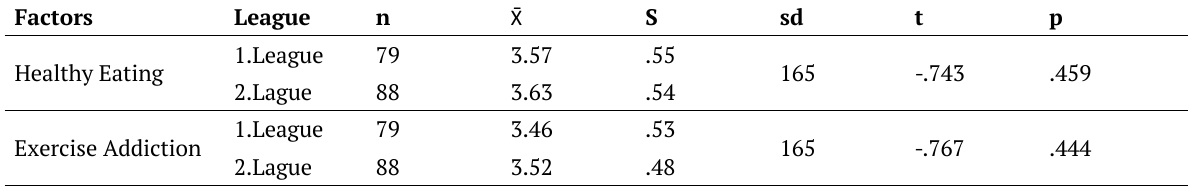
Table 3. T-test results of female football players’ attitude to healthy eating and exercise addiction status by league